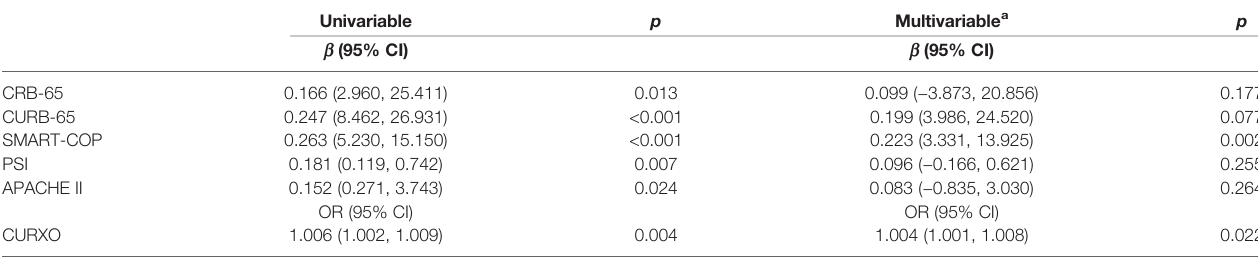
TABLE 3 | Associations between serum S100A12 and CAP severity scores in CAP patients.